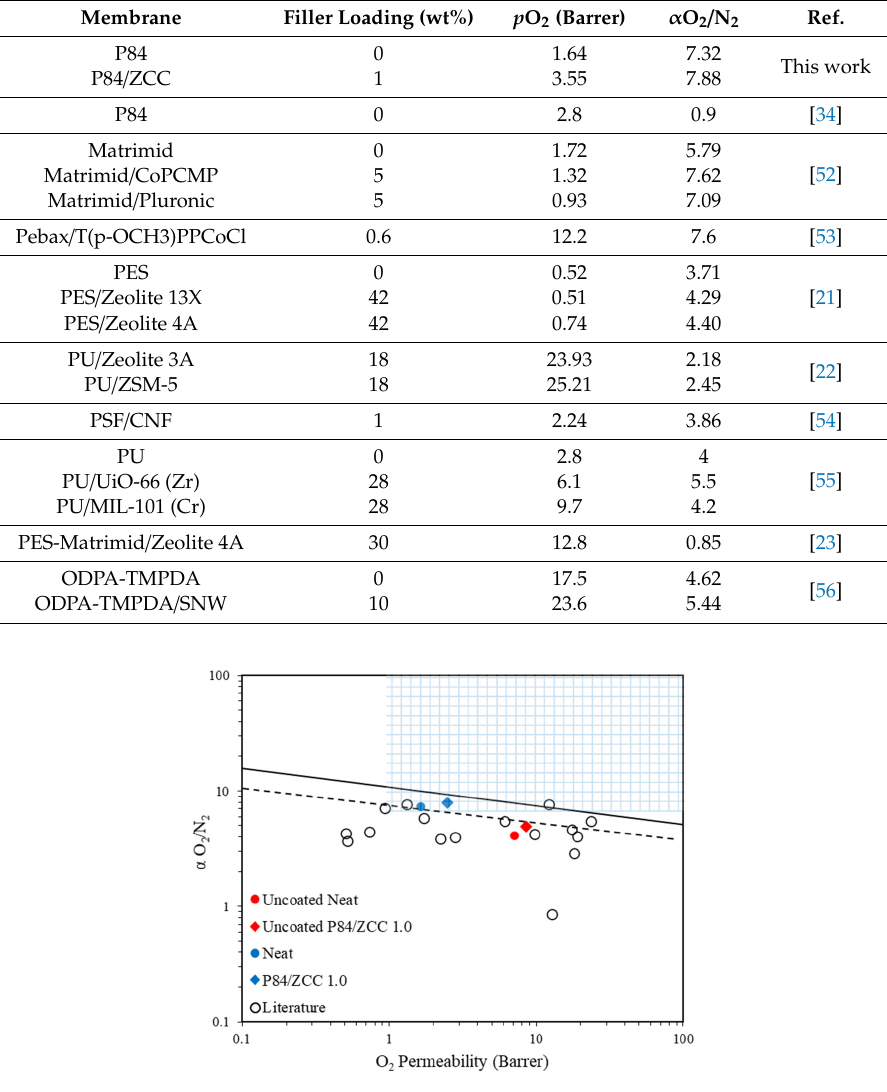
Table 2. The O 2 / N 2 separation performance of MMMs studied here as compared to the previously reported study.